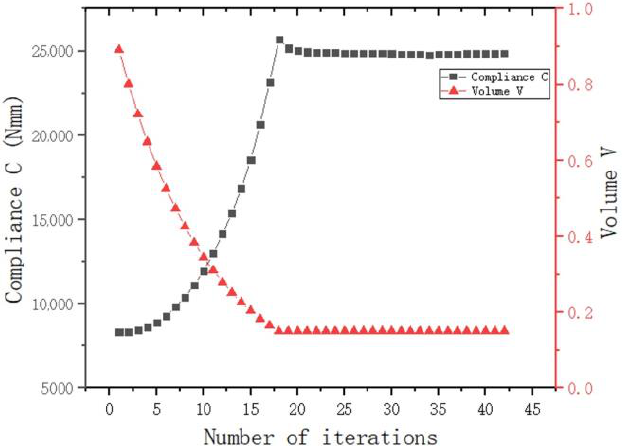
Figure 12. Schematic diagram of optimization results under combined conditions: ( a ) cutaway view; ( b ) stress nephogram.